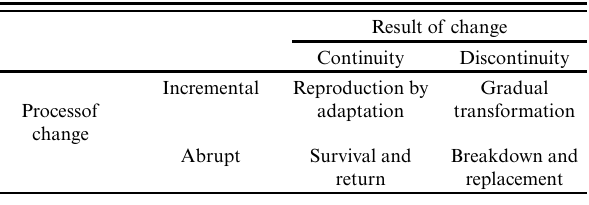
Table 2 . Process and result of institutional change (Streeck and Thelen